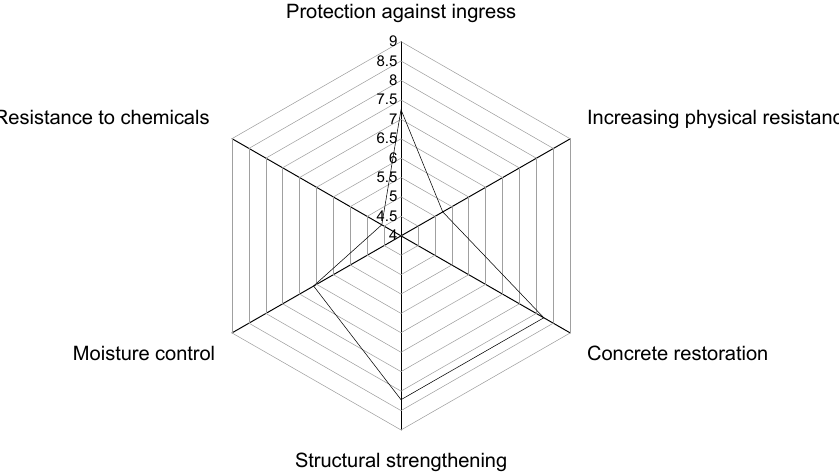
Figure 6. Weighting of overall repairing principles.